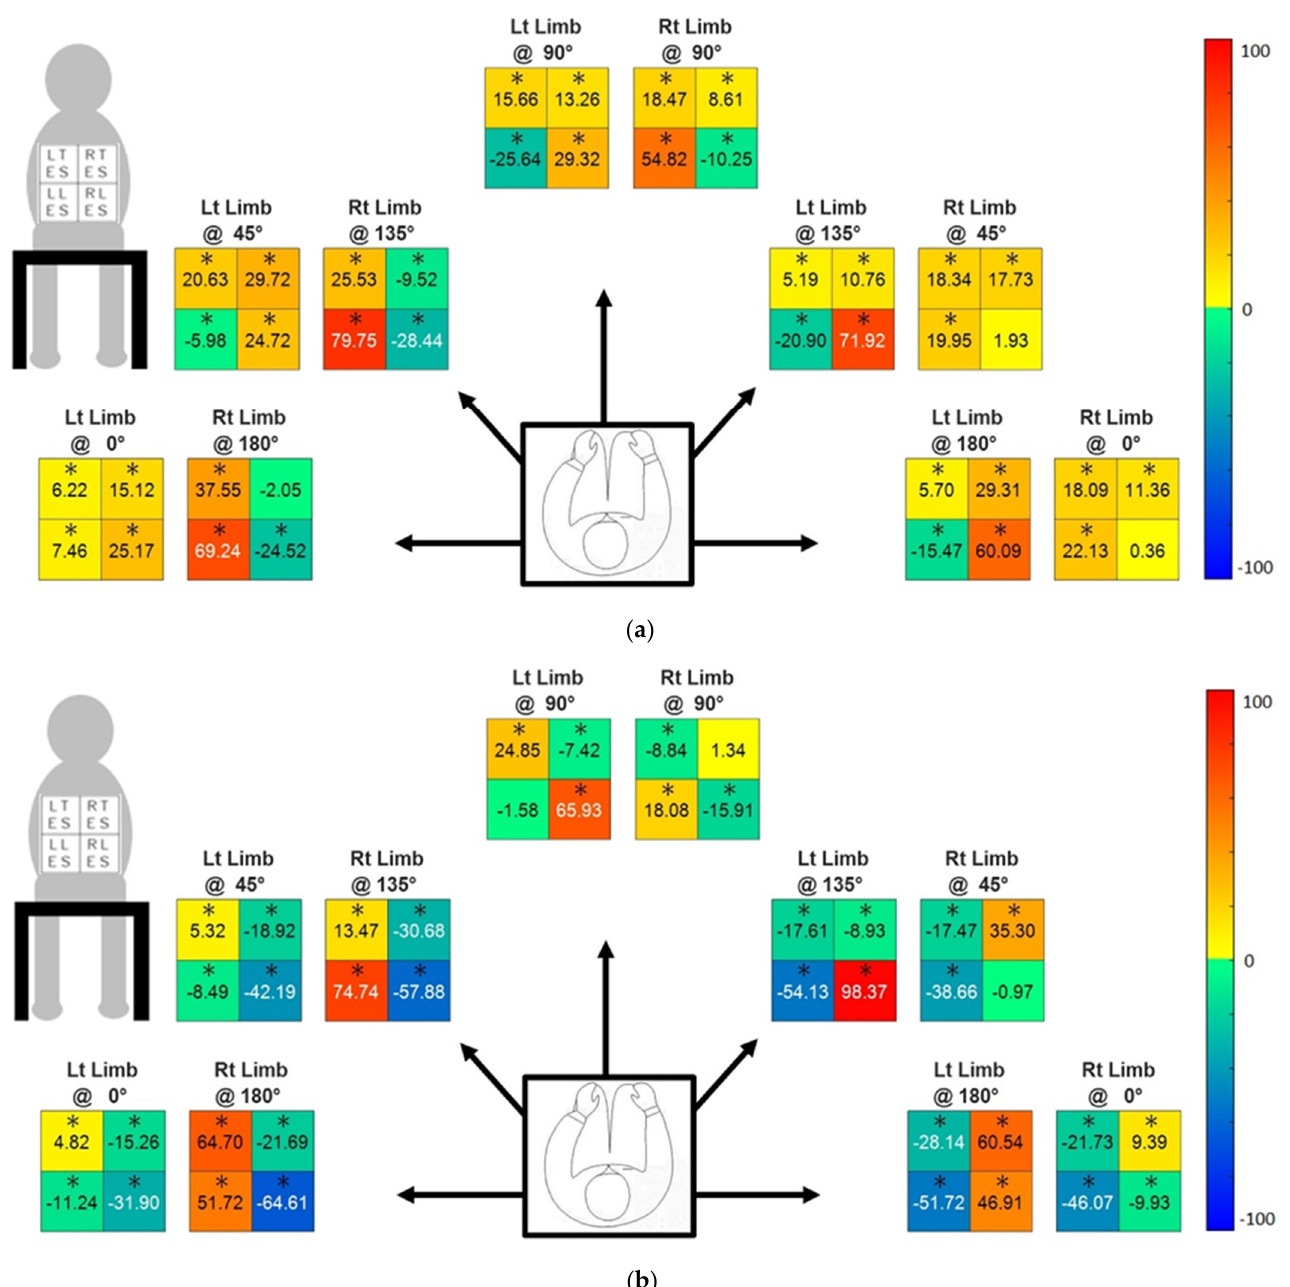
Figure 3. Percent change for ( a ) Extend stage and ( b ) Reach stage, in the EMG mean absolute value (MAV) due to CMPTO. The four values within each heatmap represent each of the four muscles (LTES, RTES, LLES, and RLES muscles), whose order is shown near the top left corner. The five pairs of heatmaps represent the five orientations (0°, 45°, 90°, 135°, and 180°). Each pair of heatmaps represent the data when using either limb (Rt: right, Lt: left). The scale bar on the right side gives the range of intensities with corresponding numeric values, as used in heatmaps. An asterisk over individual value indicates a significant change in muscle activity due to CMPTO use ( p = 0.05).